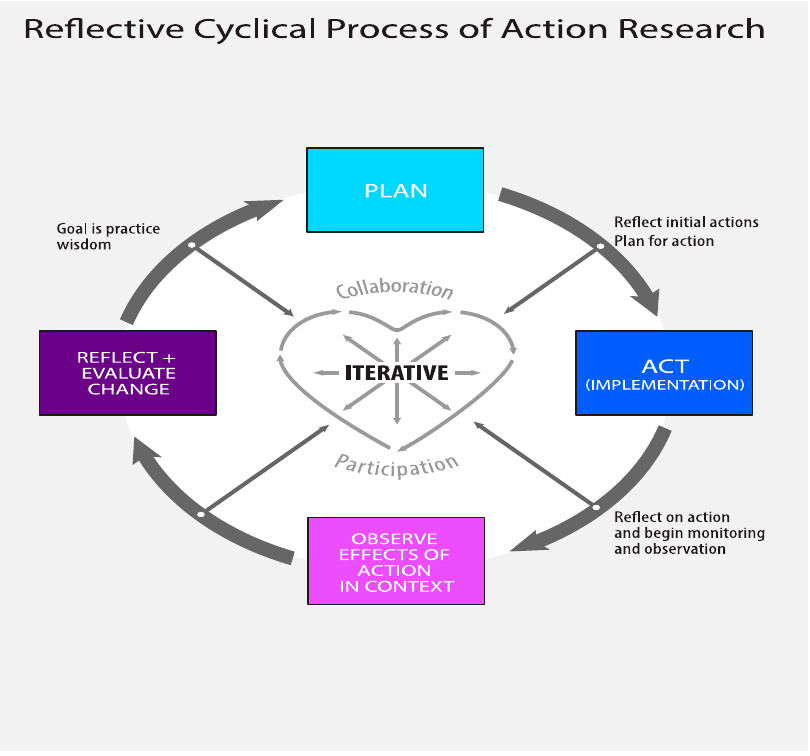
Figure 1. Reflective cyclical process of action research. Adapted with permission from [27], 2019, Rault.